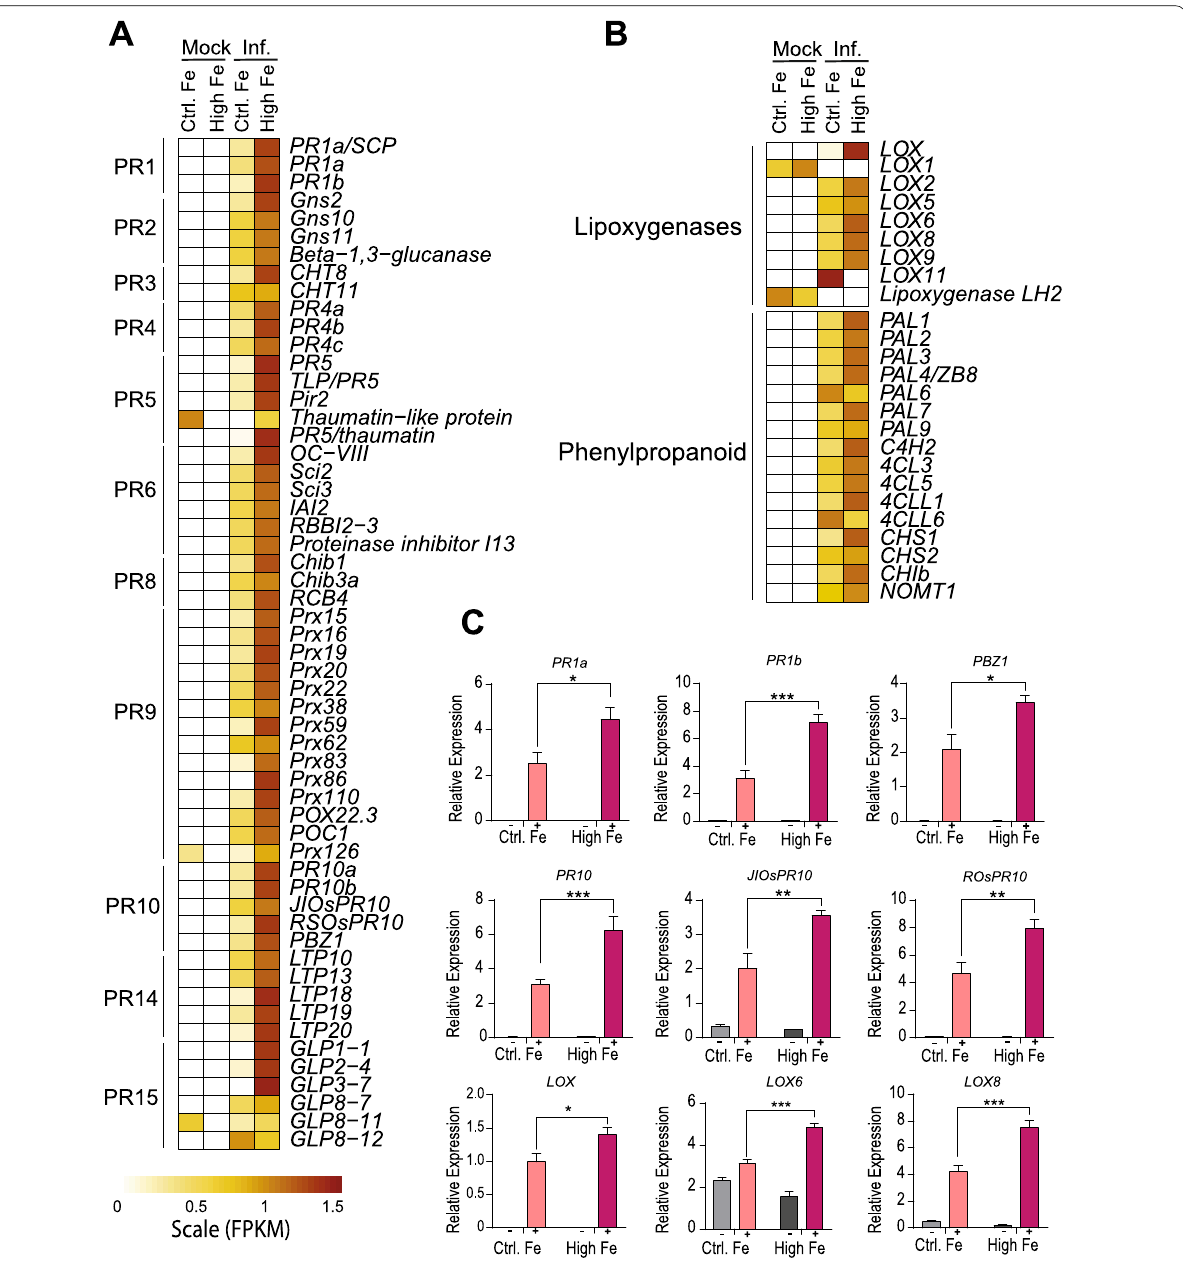
Fig. 5 Expression of genes involved in defense responses in leaves of Control and High‑Fe plants. Heat maps (A and B) show the expression pattern of DEGs identified by RNA‑Seq analysis (Mock and infection conditions, 48 hpi) as row scaled FPKM (fragments per kilobase per million reads), from pale yellow (less expressed) to brown (more expressed). A Expression of Pathogenesis-Related ( PR ) genes. B Expression of lipoxygenase and phenylpropanoid genes. Gene names, locus IDs, FPKMs and fold change values are indicated in Additional file 5: Table S4. ( C ) Transcript levels were determined by RT‑qPCR analysis ( , mock‑inoculated; , M. oryzae ‑inoculated). The expression values were normalized to the rice Ubiquitin1 − + gene. Four independent biological replicates were examined. Data are mean SEM. Asterisks indicate statistical significance calculated by two‑way ± ANOVA (*, P < 0.05; **, P < 0.01, *** P < 0.001). Gene‑specific primers are listed in Additional file 9: Table